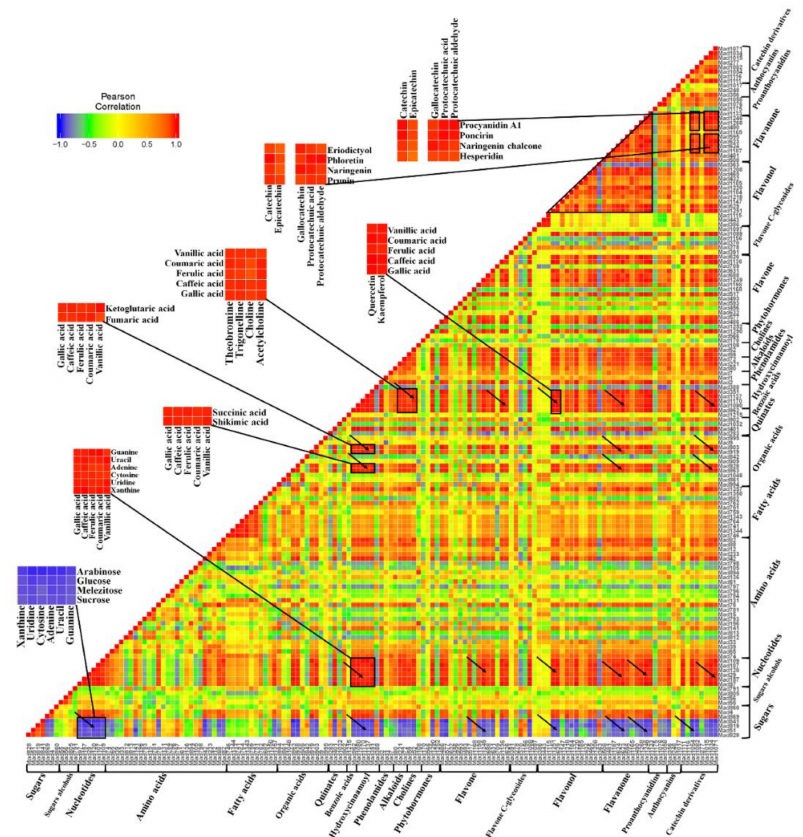
Figure 7. A heat map of metabolite–metabolite correlations along with the apple development: 149 representative metabolites were selected from the total 462 metabolites to analyze their correlations. Pearson algorithm was applied to assess metabolite–metabolite correlation coe ffi cients using R software. Each square of the heat map indicates a correlation coe ffi cient score resulting from Pearson